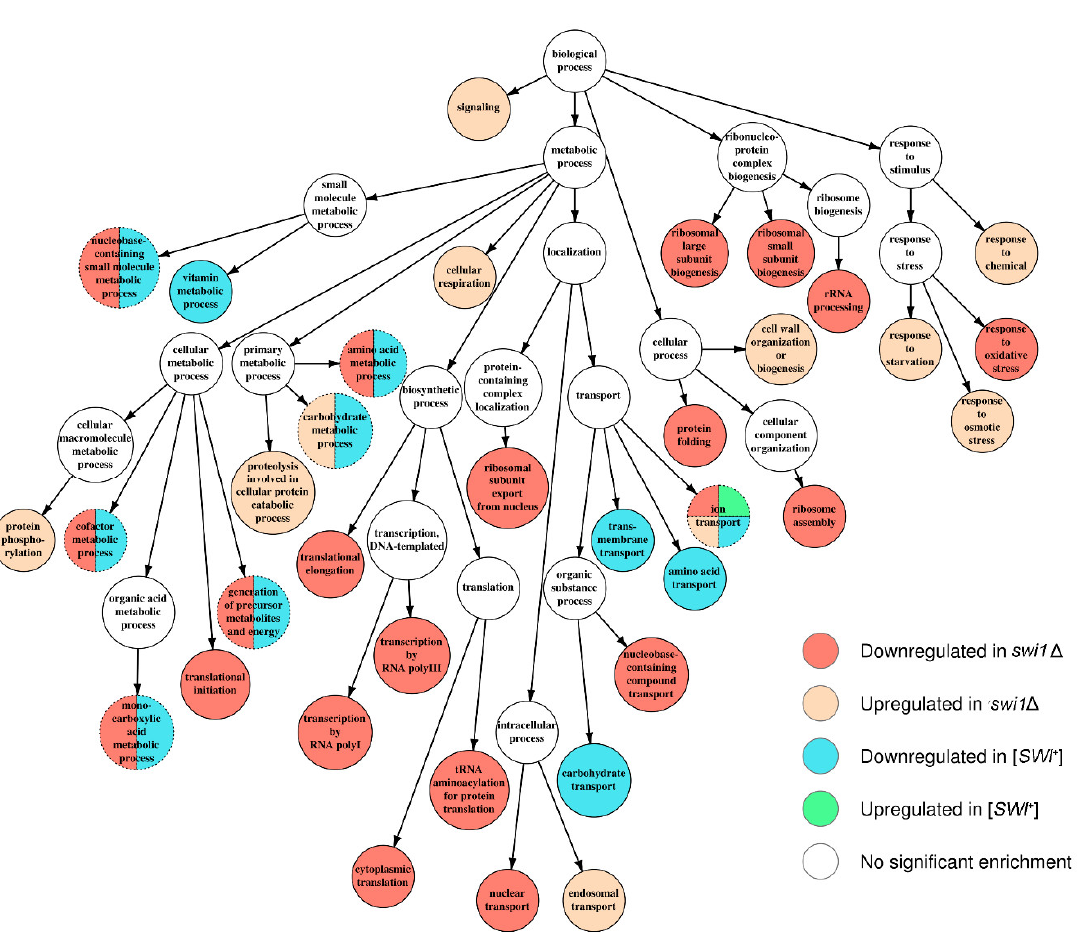
Figure 4. Graph of over-represented terms from Biological Process (BP) Gene Ontology. Several internal nodes and reticular edges were deleted to improve representativeness. For a full resolution image, see Figure S1.